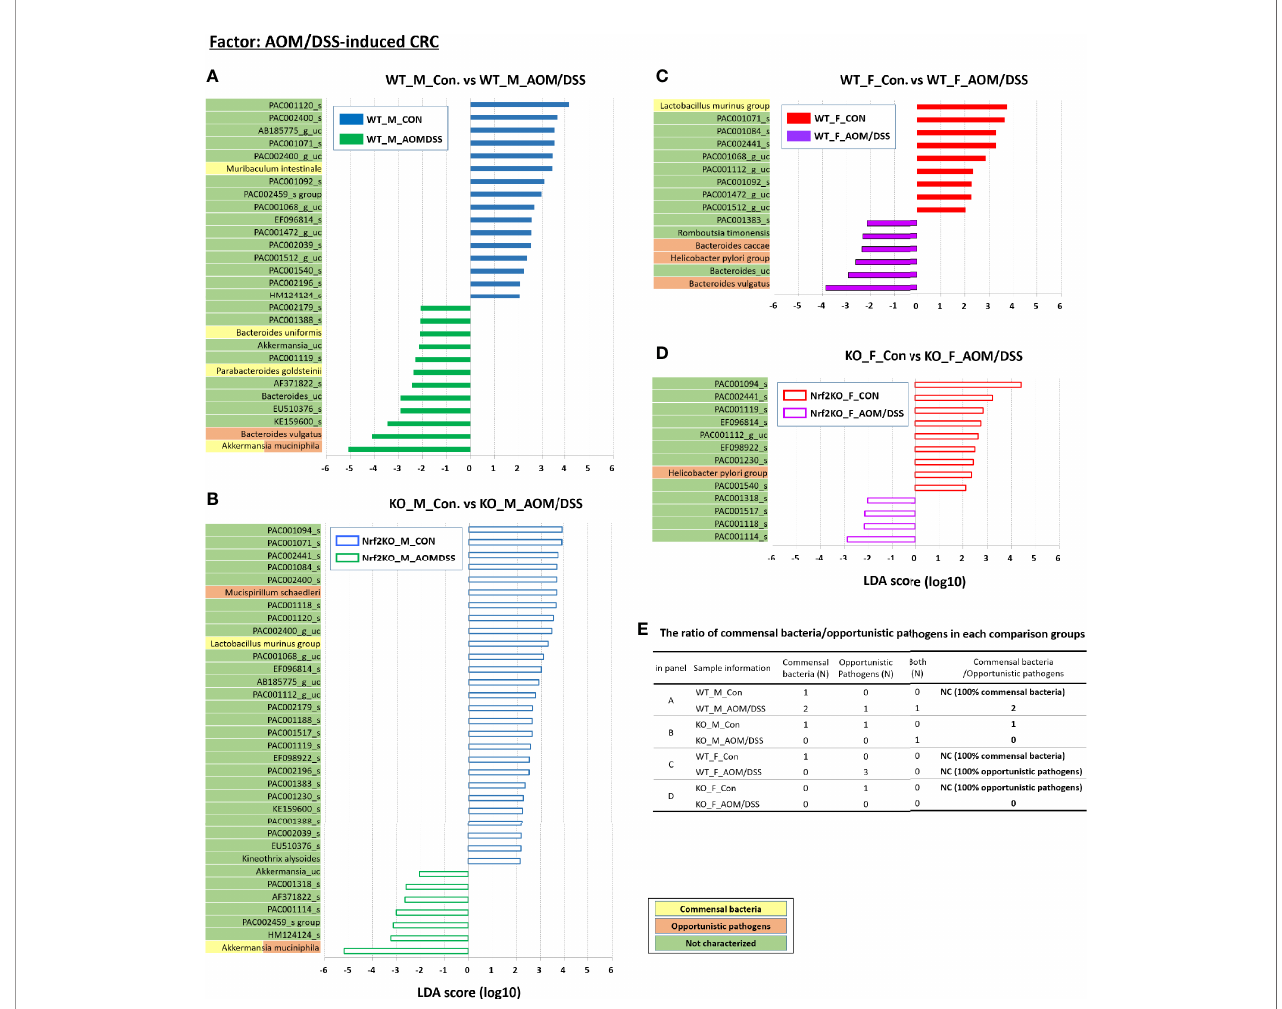
FIGURE 6 | CRC-speci fi c alterations in the abundance of gut microbiota examined using LEfSe. Bar plots of the LEfSe results, which were generated based on the criteria mentioned in the legend of Figure 5. Bar plots at the species level with signi fi cant differences in abundance based on LEfSe. The color bars and lines show the LDA scores of species that were enriched in the indicated condition; (A) blue bar (WT male controls), (A) green bar (WT male AOM/DSS-induced CRC), (B) blue line (Nrf2 KO male controls), (B) green line (Nrf2 KO male AOM/DSS-induced CRC), (C) red bar (WT female controls), (C) purple bar (WT female AOM/DSS-induced CRC), (D) red line (Nrf2 KO female controls), and (D) purple line (Nrf2 KO female AOM/DSS-induced CRC). Each color on the species name indicates the characteristics of each genus: yellow for commensal bacteria, orange for opportunistic pathogens, and green for not characterized bacteria. The p -values were calculated using the non-parametric factorial Kruskal – Wallis sum-rank test. (E) The ratio of commensal bacteria to opportunistic pathogens based on the LEfSe results in each comparison group. CRC, colorectal cancer; LDA, linear discriminant analysis; LEfSe, LDA effect size; WT, wild-type; KO, Nrf2 knockout; Con, control; AOM, azoxymethane; DSS, dextran sodium sulfate; M, male; F, female; N, number; NC, not